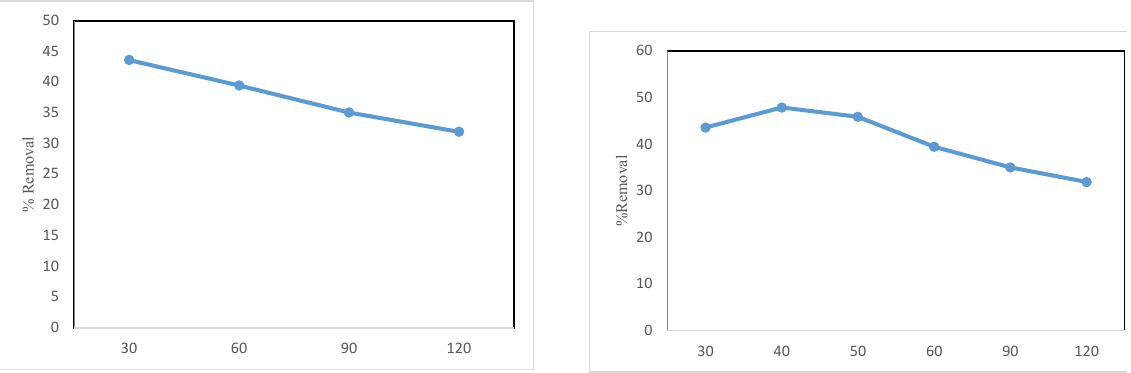
Fig. 3. The removal efficiency of Ni (II) by ferrous sulfate at different contact times (30, 40, 50, 60, 90, and 120 min)